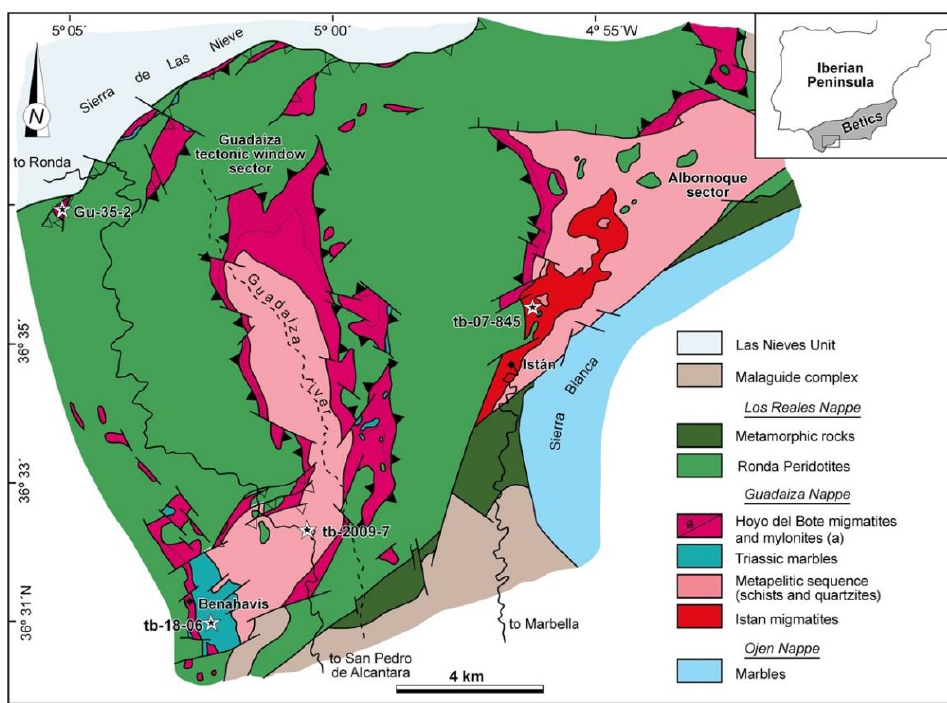
Figure 1. Geological map of the Guadaiza nappe (modified from Esteban et al. [16]) and analysed sample locations (stars).